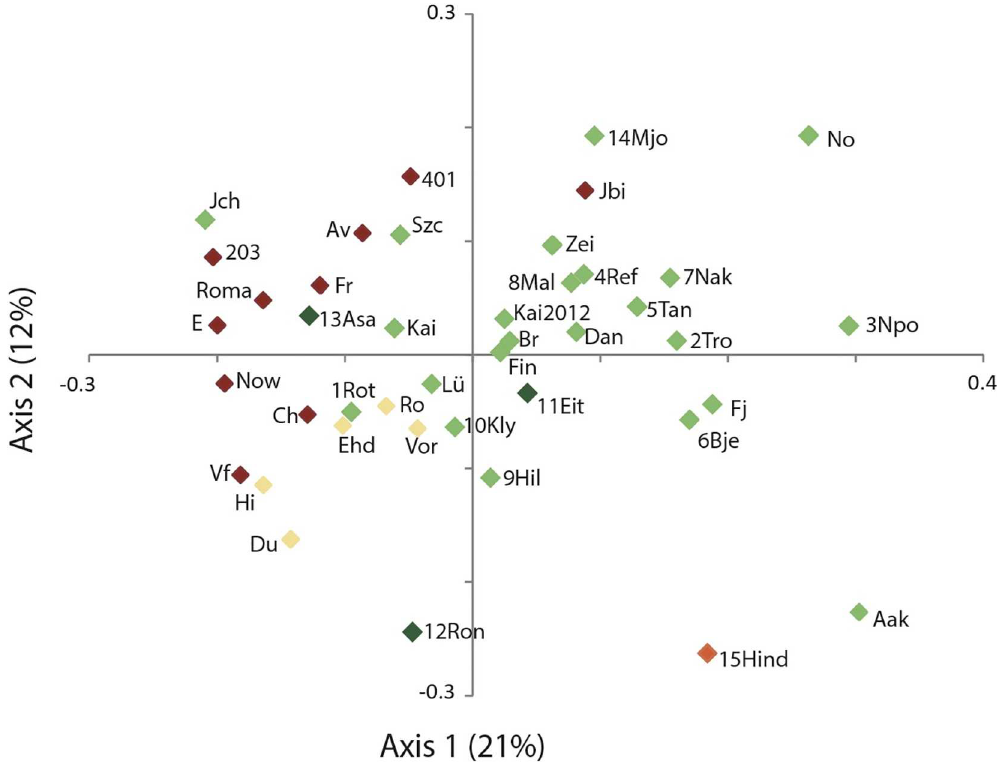
Fig 3. Principal Coordinates Analysis (PCoA) plot of the first and the second principal coordinates based on the genetic composition at six nuclear microsatellites of 42 population samples of common ash ( Fraxinus excelsior ). For populationnames see S1 Table and S1 Fig. Each populationis given the color of the STRUCTURE group (Fig 2C) in which it had the highestproportionof membership(S1